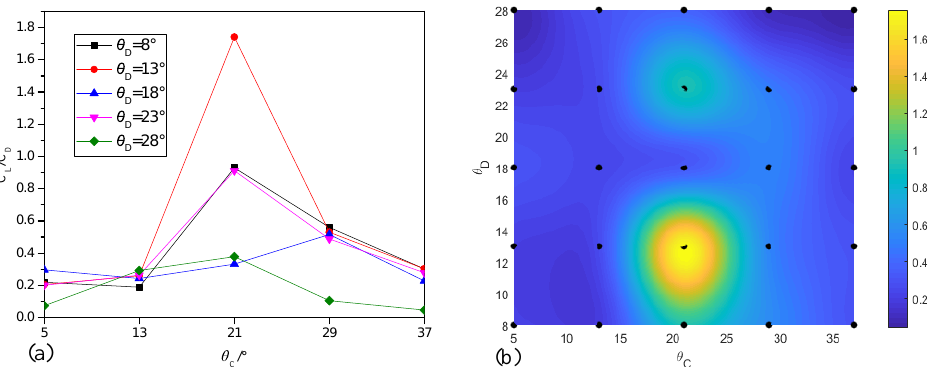
Figure 11. The lift-drag ratio: ( a ) variation with different simulation cases; ( b ) Kriging response surface